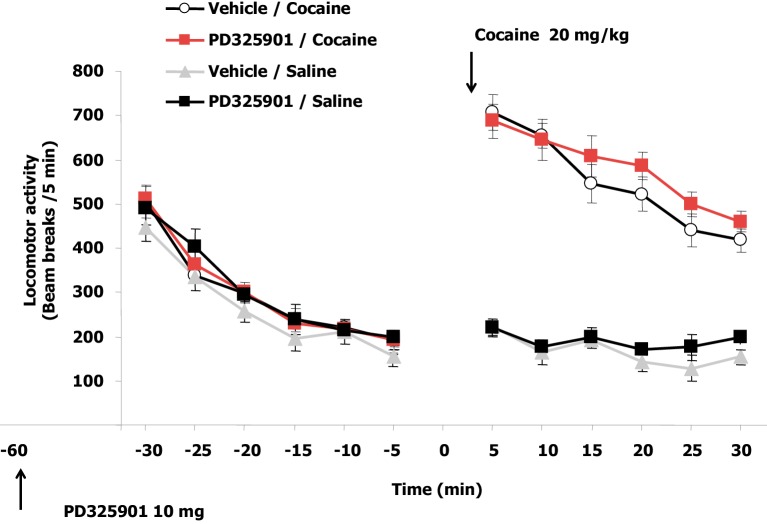
Acute administration of PD325901 at 10 mg/kg had no effect on locomotion.The horizontal activity of freely moving mice was monitored in one single session starting 30 min after PD325901 injection (10 mg/kg) and recorded every 5 min for a total of 6 trials. At the end of this session, mice received a cocaine challenge (20 mg/kg) and the effect of PD325901 pre-treatment on the hyper-locomotion induced by cocaine was evaluated for the subsequent 30 min. An acute administration of PD325901 had no effect on spontaneous locomotion. Two way ANOVA for repeated measures, showed that levels of locomotor activity were comparable among the groups (F3,36 = 1.195, p=0.326). There was a significant main effect of time on spontaneous locomotion across the 30 min of testing (F5,180 = 128.833, p<0.0001), but no significant time x group interaction (F15,180 = 0.549, p=0.909), demonstrating that there were no differences in the rate of explorativity of all groups. Analysis of the percentages of habituation to the environment confirmed that there were no differences among groups (One-way ANOVA, F3,39 = 0.180, p=0.909). A significant enhancement of locomotion was observed upon cocaine challenge, without any difference between PD325901 and vehicle pre-treated groups (Three-way ANOVA, Coc group effect: F1,36 = 236.787, p<0.0001; PD group effect: F1,36 = 1.216, p=0.278; interaction Coc group x PD group: F1,36 = 0.042, p=0.839). Moreover, a significant effect of habituation across the 6 time points was found (Three-way ANOVA, time effect: F5,180 = 22.851, p<0.0001). A significant interaction with time was found for the cocaine group effect but not for the PD group effect (Three-way ANOVA, interaction time x cocaine group: F5,180 = 12.016, p<0.0001; interaction time x PD group: F5,180 = 1.127, p<0.348). Data are shown as mean with SEM.